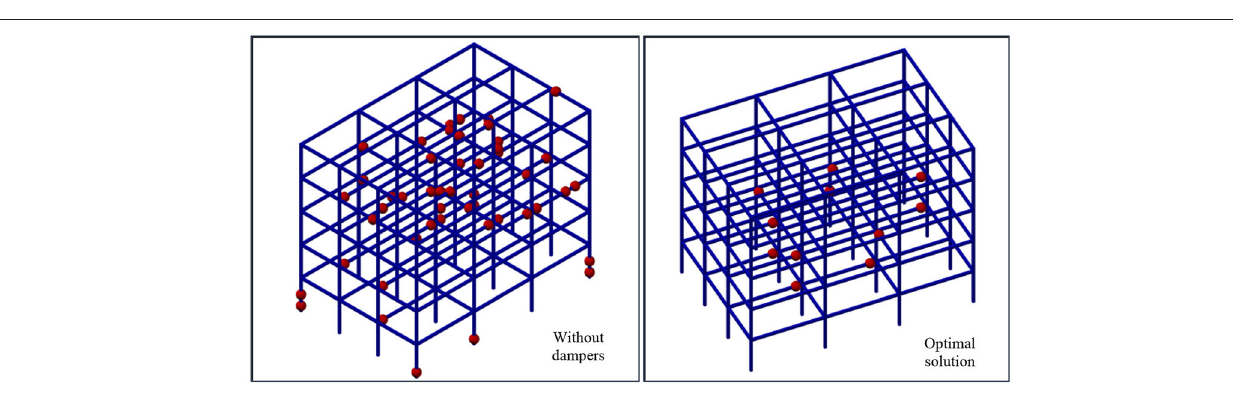
FIGURE 20 | Occurrence of plastic hinges in the structure without dampers and the structure with the optimal solution.